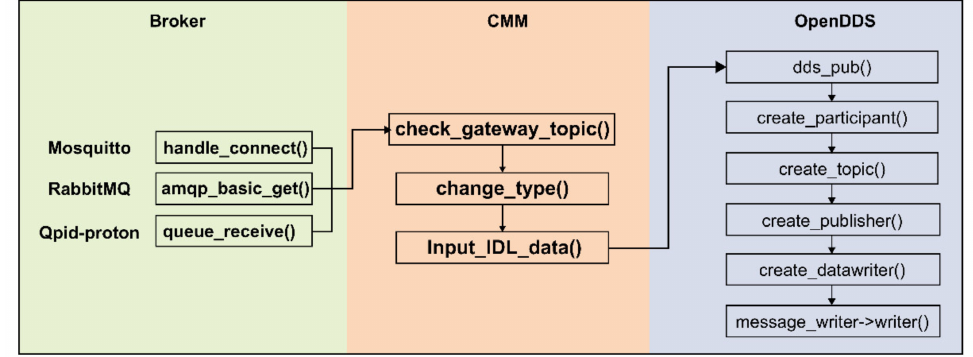
Figure 9. Overall software architecture of DDS gateway. Figure 10 and Algorithm 1 show an example of the IDL mapping process and the QoS setting,